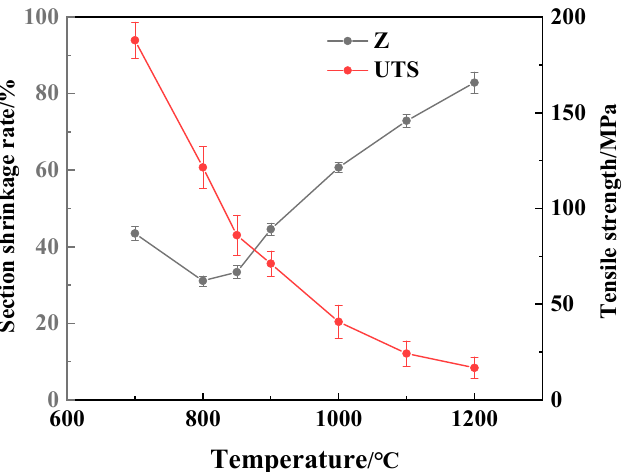
Figure 3. Section shrinkage rate and tensile strength at different temperature.